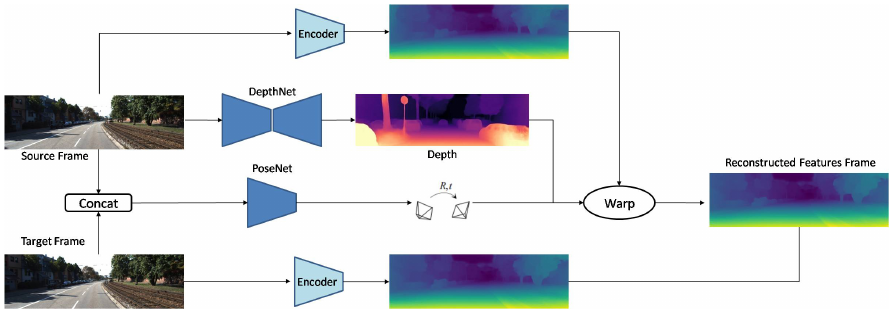
Figure 5. Developed network by Shu et al. [84].